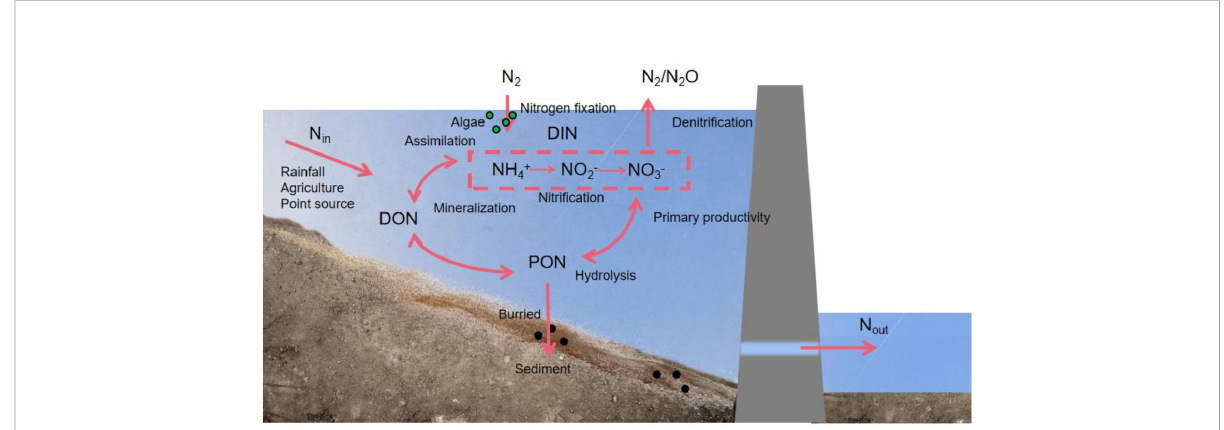
FIGURE 1 Biogeochemical transformation mechanism of nitrogen in a reservoir. DON:dissolved organic nitrogen; PON:particle organic nitrogen; DIN: dissolved inorganic